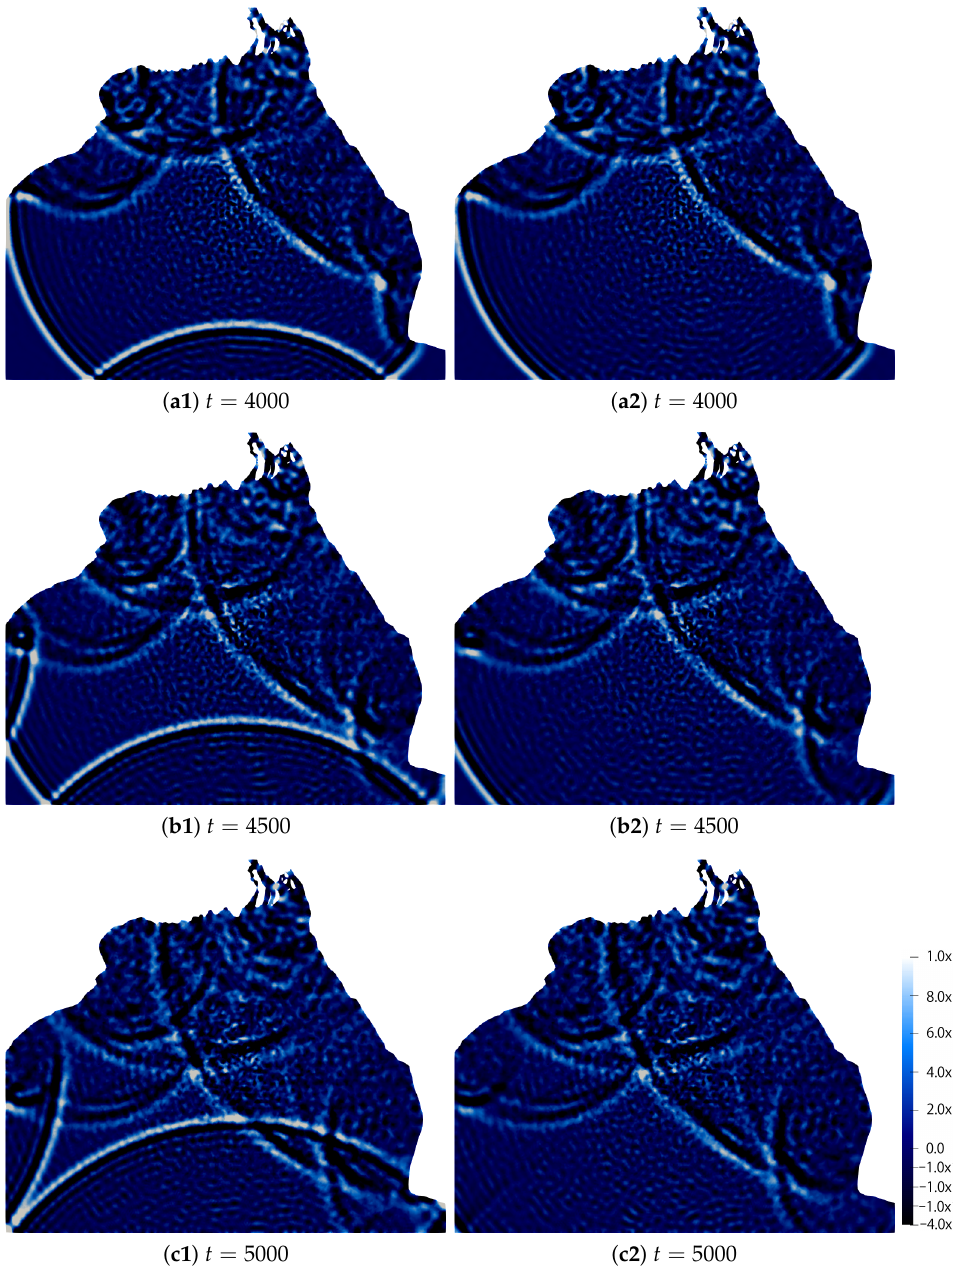
Figure 10. Contour plot of η n by LG2 with Γ = Γ D ( left ) and Γ = ¯ Γ D ∪ ¯ Γ T ( right ) on the Bay of Bengal h for t = 4000,4500 and